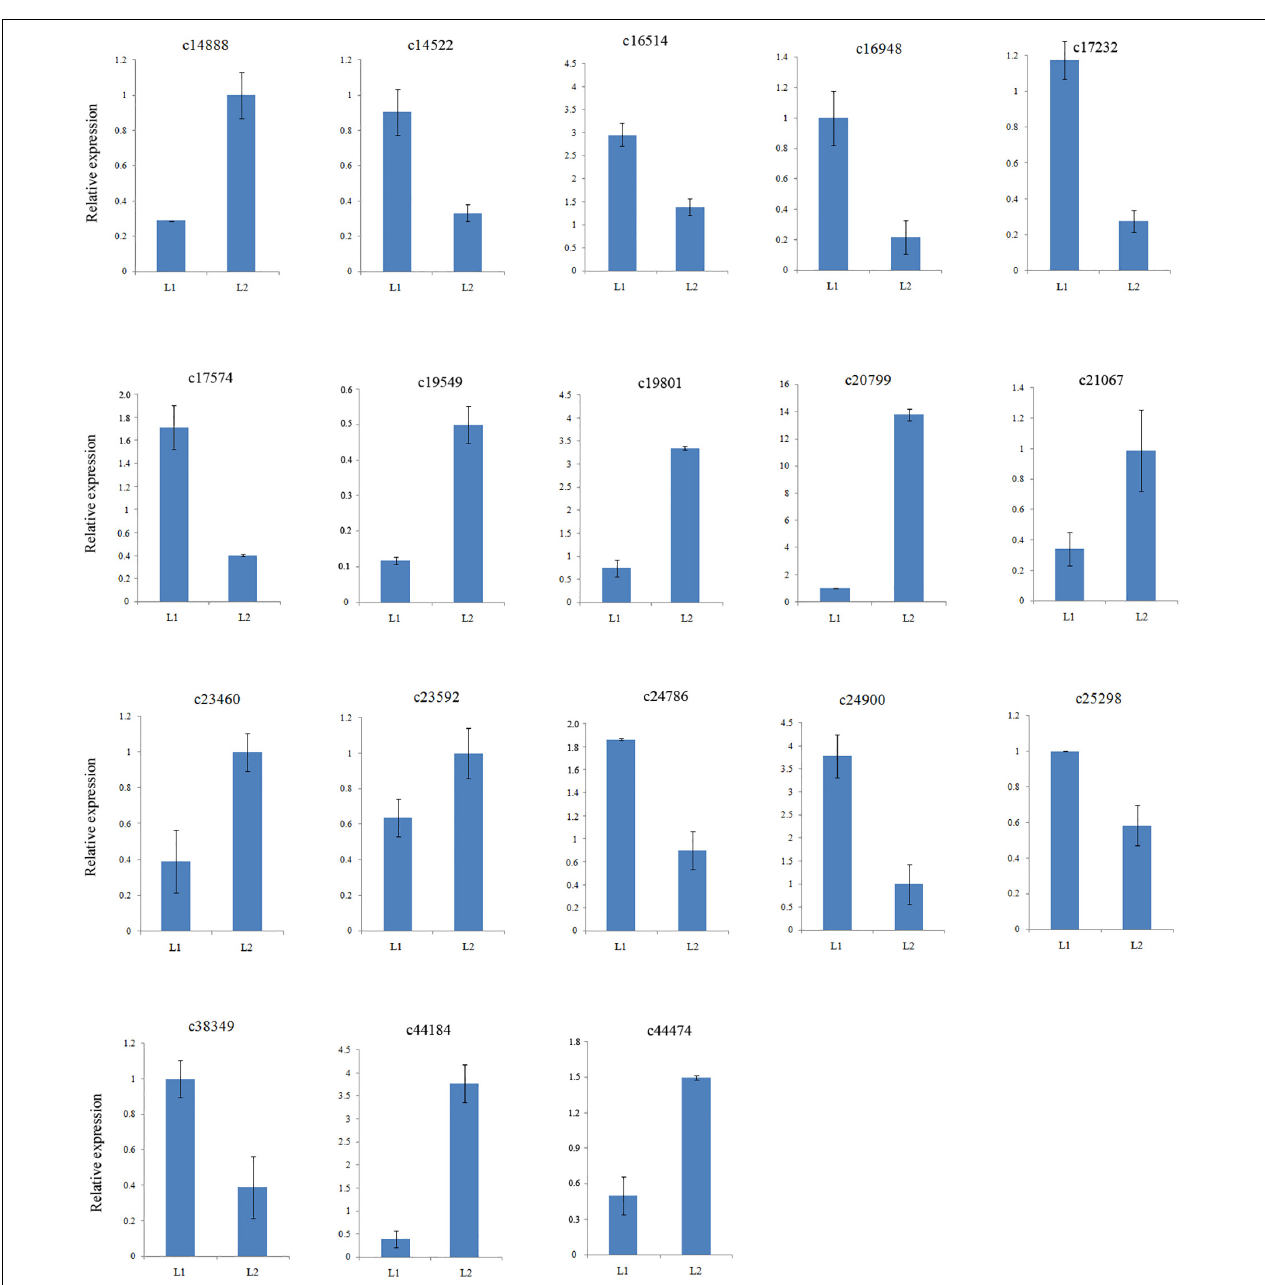
FIGURE 3 | Validation of assembled unigenes by